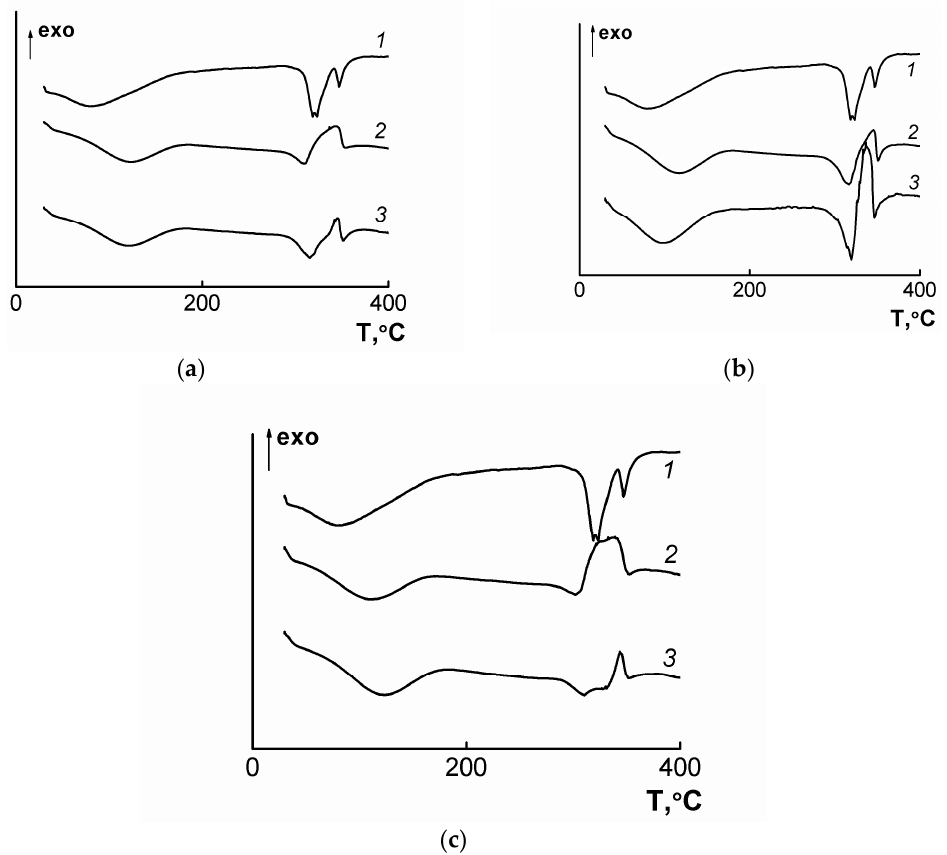
Figure 7. DSC curves for cellulose (1) and composite fibers: ( a ) T-5 (2), T-10 (3); ( b ) VT-5 (2), VT-10 (3); ( c ) B-5 (2) and B-10 (3). Atmosphere: argon 10 cm 3 /min. Linear heating at a rate of 10 °C/min.